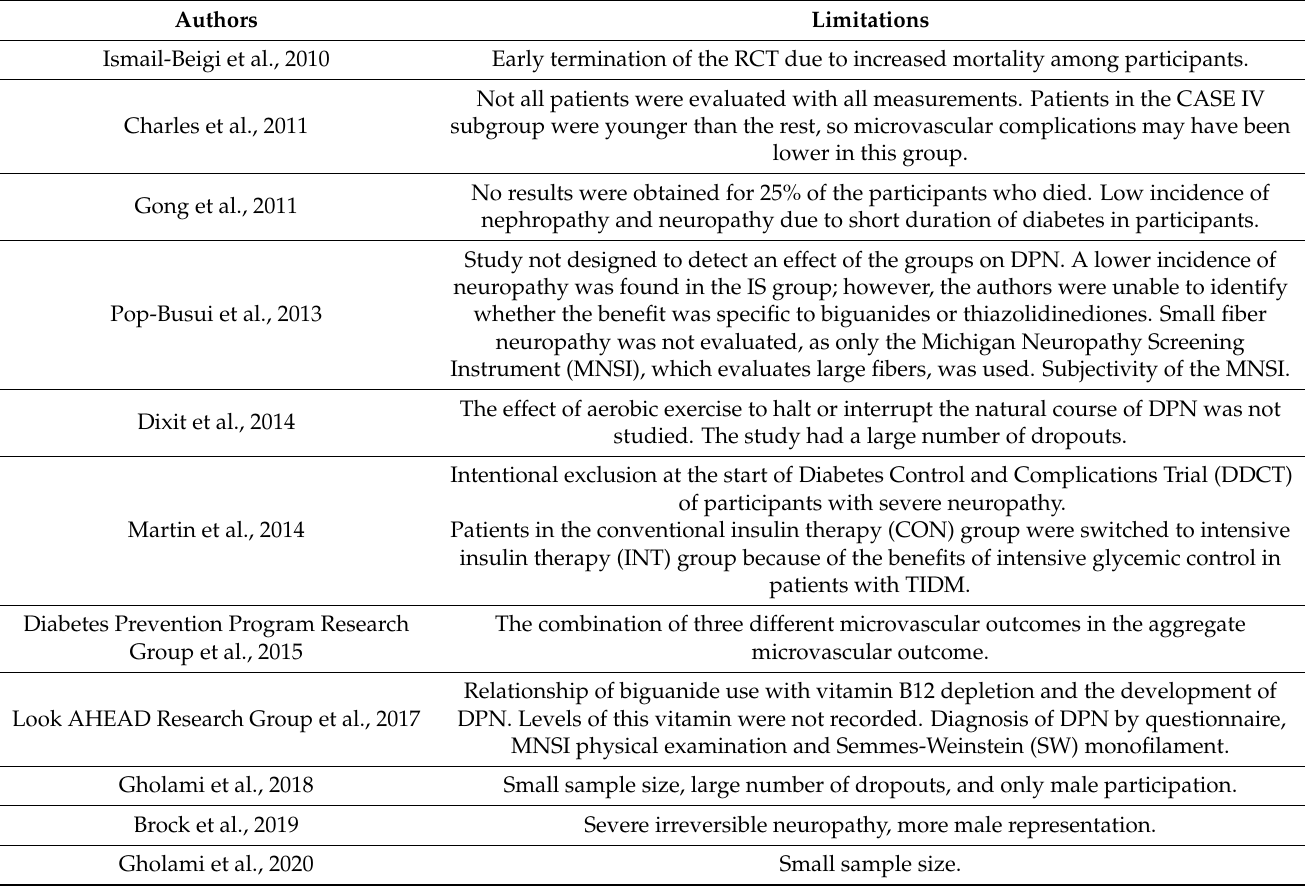
Table 4. Limitations of the